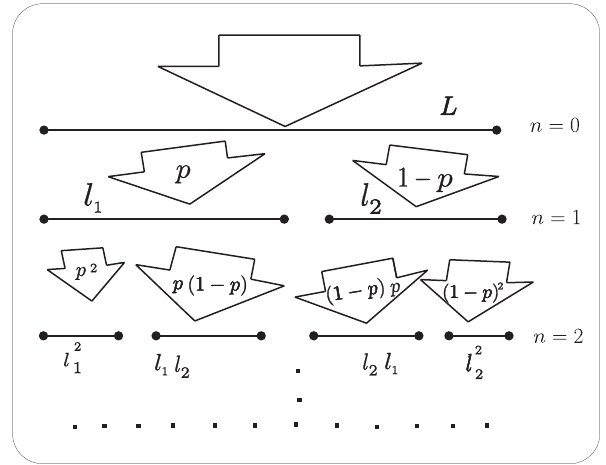
Fig. 1. Two-scale weighted Cantor set model for asymmetric solar wind turbulence, taken from Macek (2007).